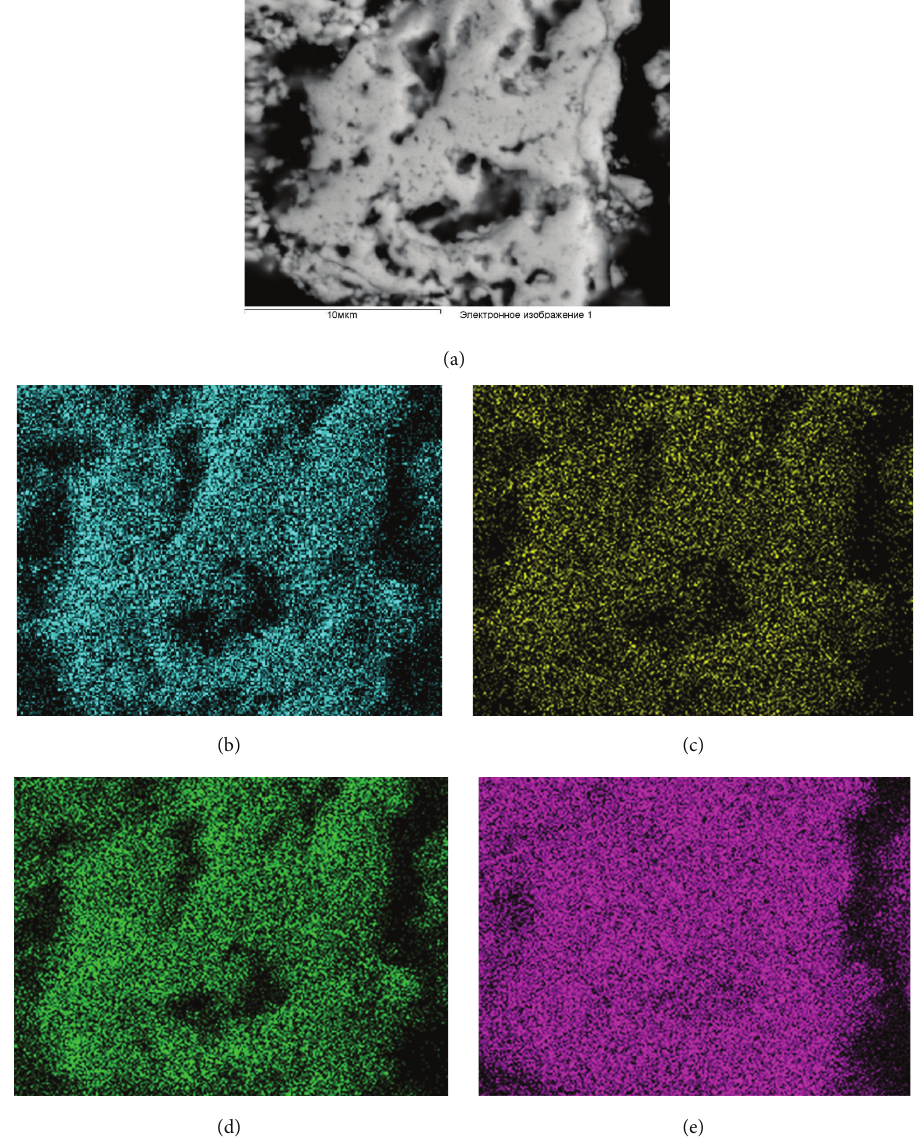
F 2: Distribution of elements in NaEu